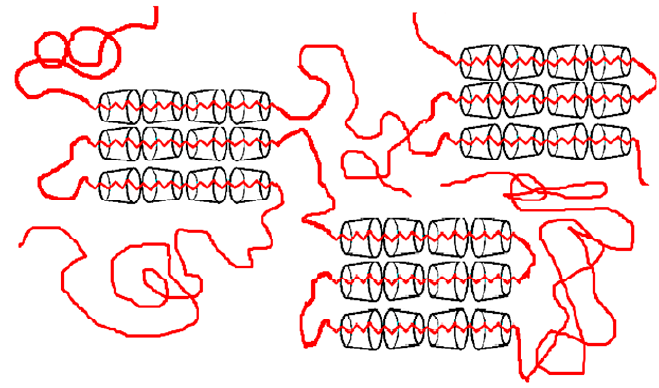
Figure 1. Schematic drawing of a non-stoichiometric (n-s) polymer–cyclodextrin (CD) inclusion compounds (IC).